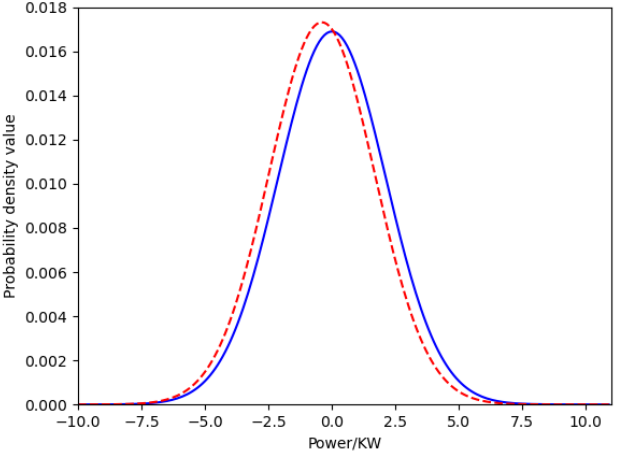
Figure 7. Statistics of power supply and demand deviation in simulation operation for optimal scheme under two scheduling models.